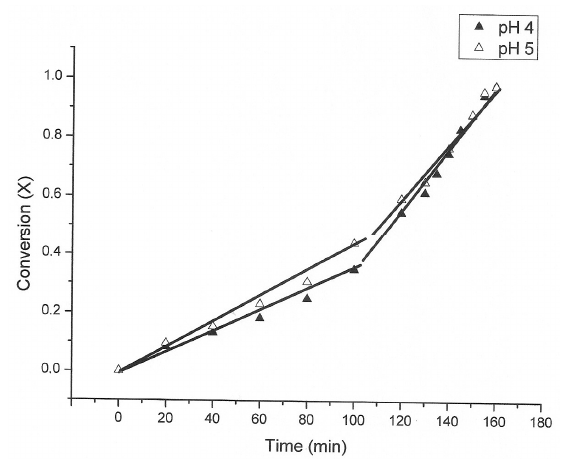
Figure 1. Nature of the reaction for thiosulfate transformation using Cu 2+ and oxygen: [S 2 O 32 − ] initial , 1